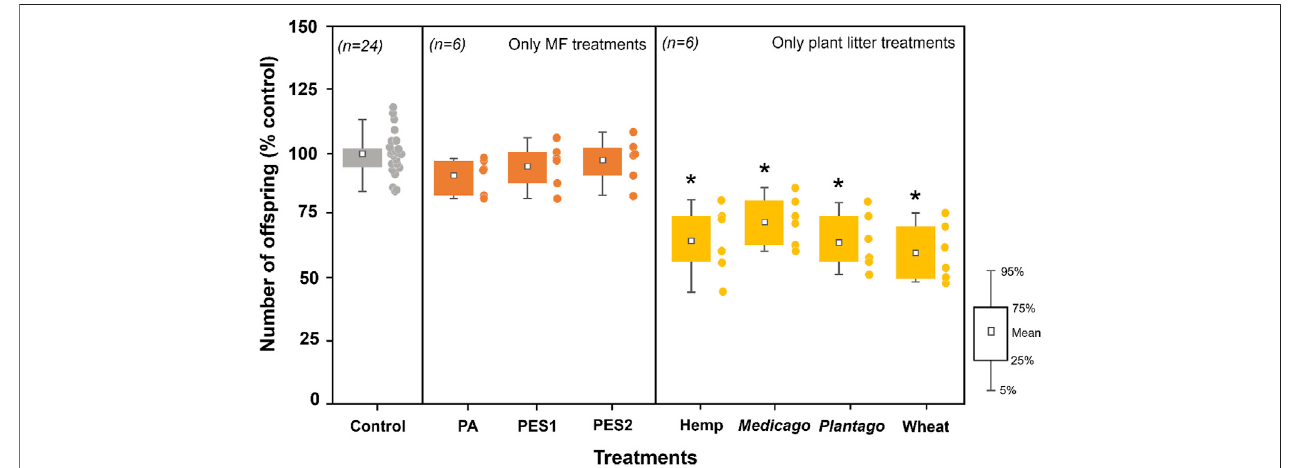
FIGURE 1 | Effects of MFs (PA, PES1, and PES2) and different types of plant litter (hemp, Medicago , Plantago , and wheat) on nematode reproduction (number of offspring)intheincubatedsoils.Alldataarenormalizedtocontrolgroup(%control),andtheasterisks(*)indicatesigni fi cant( p < 0.05)differencescomparedtothecontrol group. Tukey ’ s multiple comparison tests were used after one-way analyses of variance.